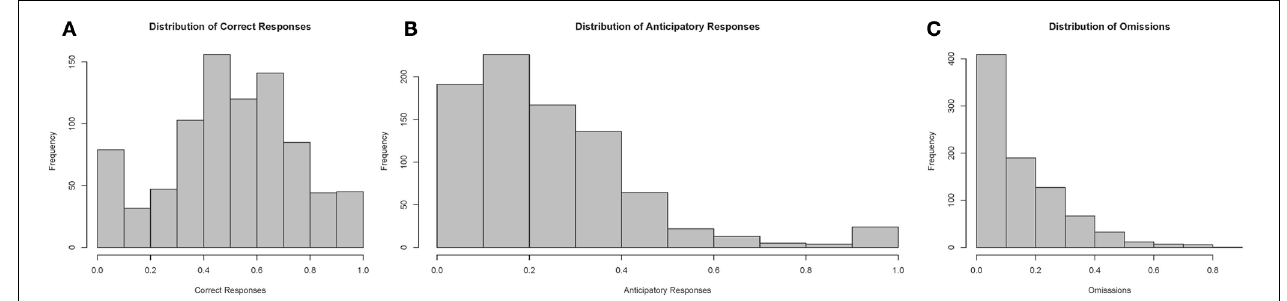
FIGURE 10 | Histograms of performance parameters. Correct responses appears to follow an approximately normal distribution, whereas premature responses and omissions were distributed with heavy right skewed tails. Note: N = 60. (A) displays the distribution of correct responses, (B) of anticipatory responses and (C) of omissions plotted according to proportion of total responses in a